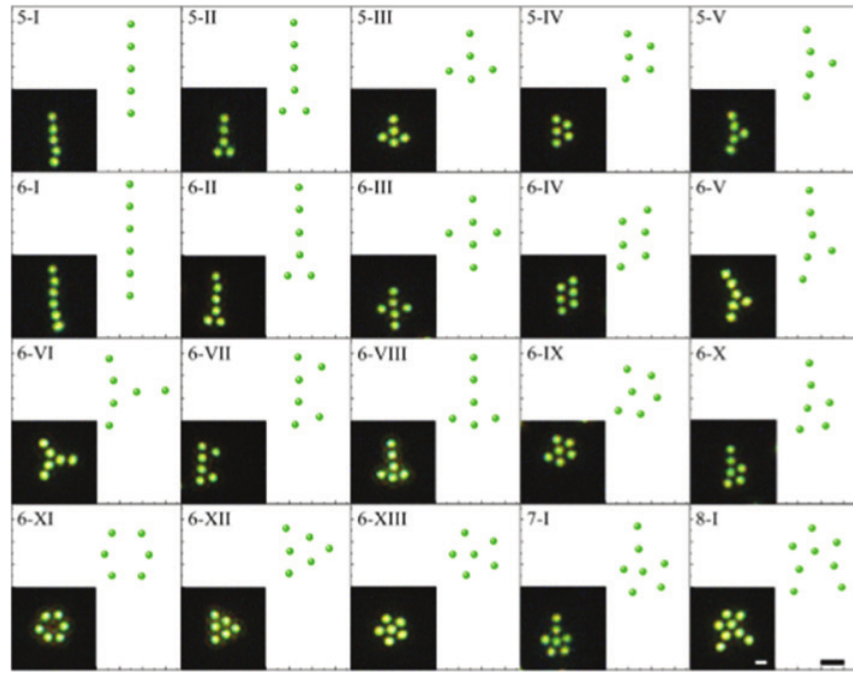
Figure 7: Predicted and observed optical matter isomers consisting of up to eight Ag nanoparticles. The plotted schematics are the equilibrium configurations predicted by simulations, while the optical images show the corresponding clusters observed in the experiments. The two scale bars in the last panel are 600 nm. Reproduced with permission from [72].